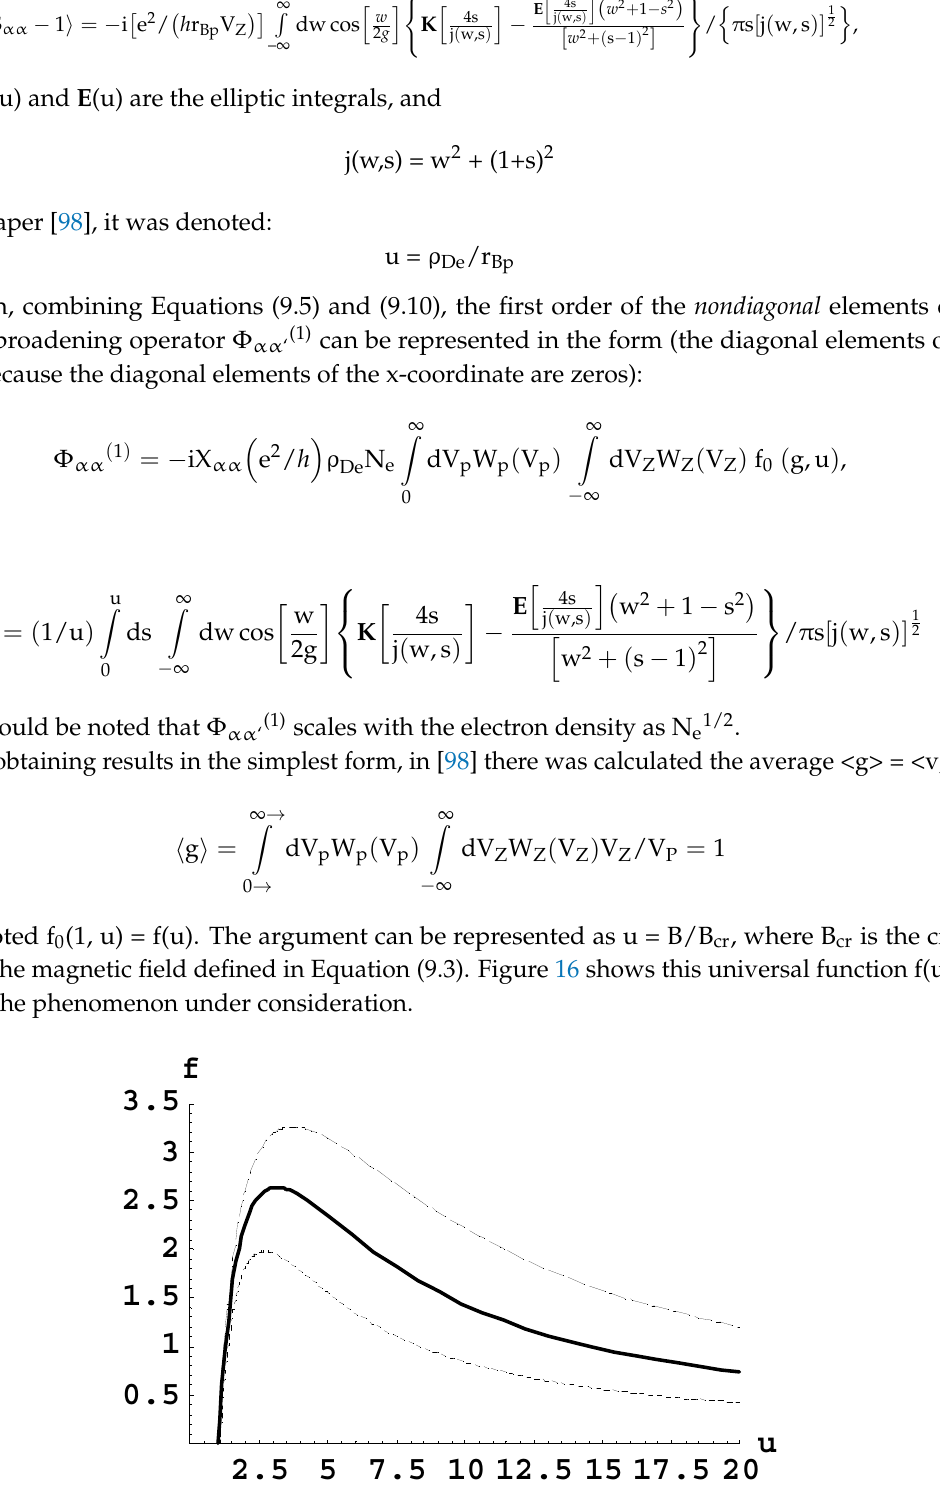
Figure 16. The universal function f(u), controlling the first order of the electron broadening operator, shown at three different values of the ratio g = v z /v p : g = 1 (solid curve), g = 3/2 (dashed curve), g = 2/3 (dotted curve). The argument u = B/B cr , where B cr is the critical value of the magnetic field defined in Equation (9.3) [98].